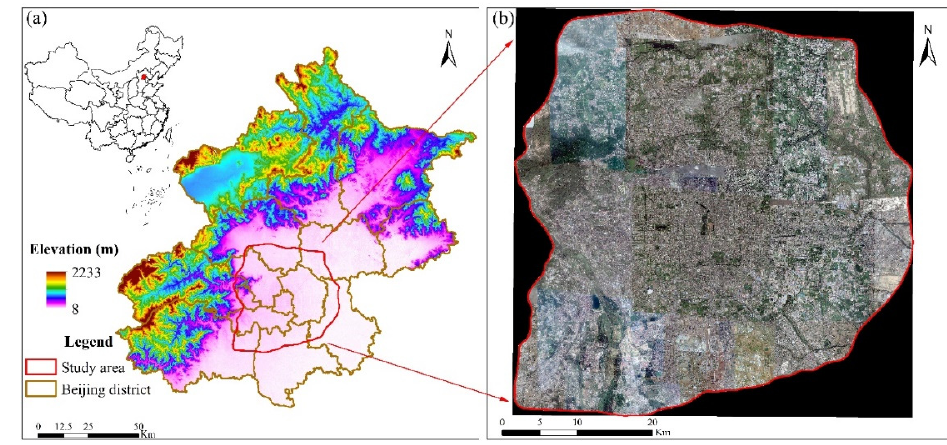
Figure 1. Study area: ( a ) location map; ( b ) Google Earth high-resolution image of summer 2017.